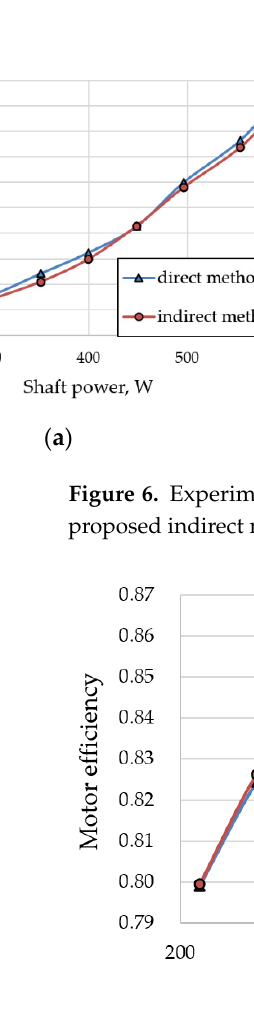
Figure 5. Experimental results: ( a ) motor current; ( b ) motor power factor.